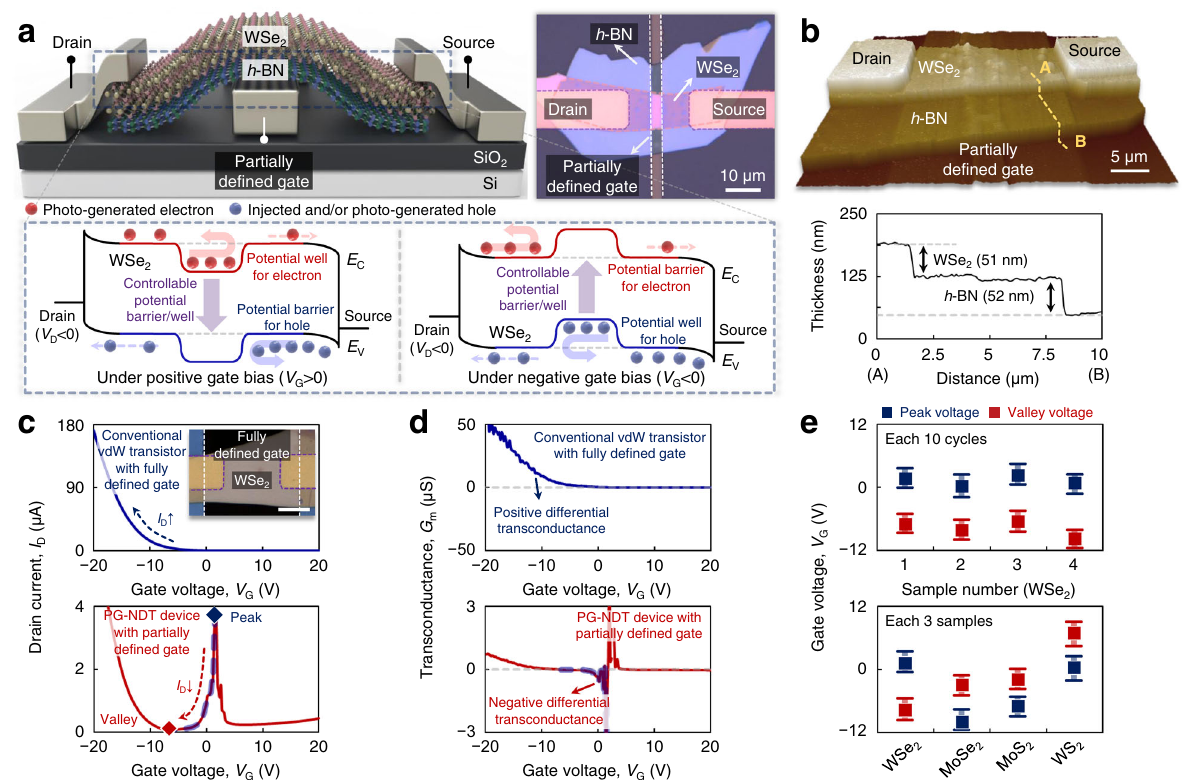
Fig. 1 PG-NDT device featuring a controllable potential barrier and/or well. a Schematic and optical microscopy images of the PG-NDT device with a partially de fi ned gate electrode (top) and energy band diagram showing a controllable potential barrier and/or well formed under positive and negative gate bias conditions (bottom). b 3D AFM mapping image of the PG-NDT device (top) and thickness pro fi les of the WSe 2 and h -BN layers at the yellow dotted line (bottom). c I D − V G characteristic curves of conventional vdW transistor with a fully de fi ned gate (top) and the PG-NDT device with a partially de fi ned gate (bottom). d G m − V G characteristic curves showing the positive differential transconductance and negative-differential transconductance phenomena. e Peak and valley voltages extracted from NDT characteristic curves, which were consistently observed in four different PG-NDT device samples (top) and in the PG-NDT device samples fabricated with various vdW channels